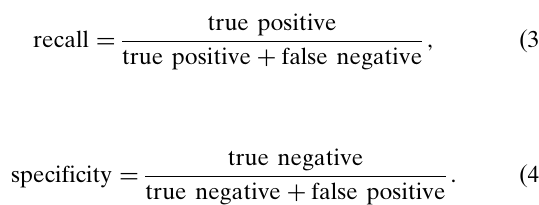
Figure 3 Schematic of the ML pipeline that can be used at a beamline for identifying single-crystal diffraction spots. A few images will be collected and manually labeled or more likely using ASM search prior to ML training. The rest of the data will be labeled using the trained